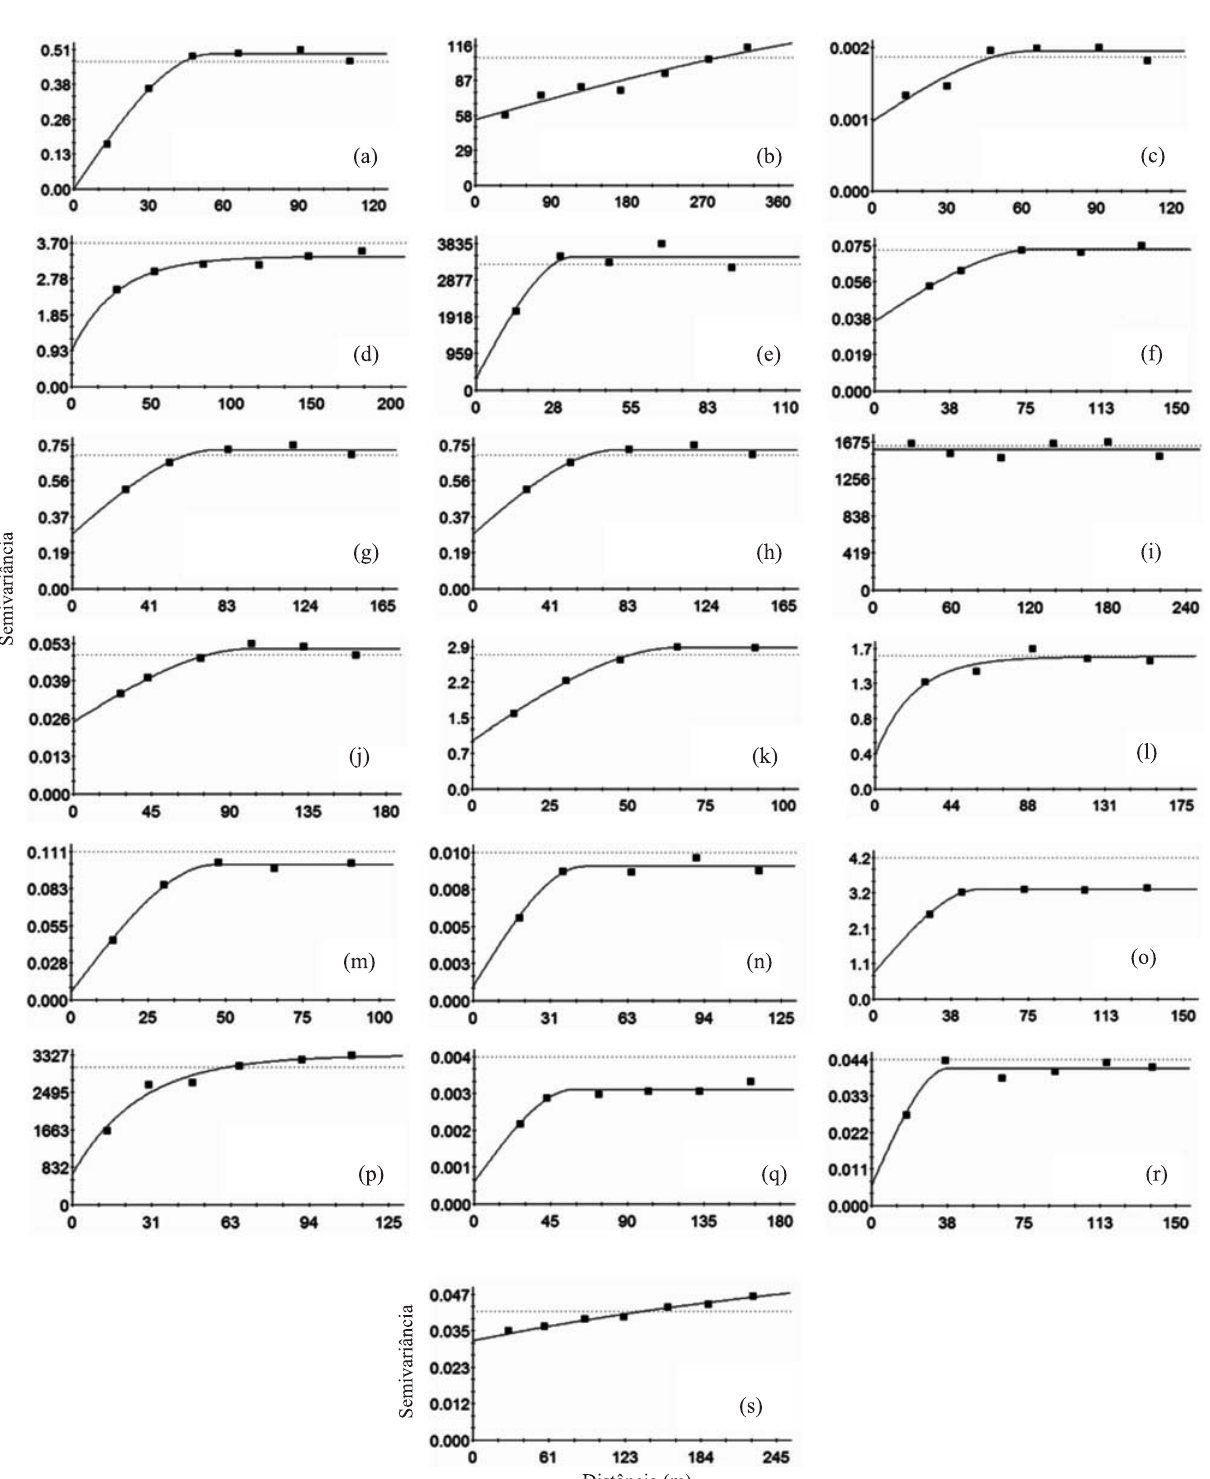
Figura 2. Semivariograma dos atributos mineralógicos: (a) FeA; (b) FeC; (c) FeA/FeC; (d) teor de Gt; (e) SI Gt; (f) DMC Gt (110); (g) teor de Hm; (h) DMC Hm (104); (i) SI Hm; (j) Gt/(Gt+Hm); (k) AlA; (l) teor de Ct; (m) Ct DMC (001); (n) IA Ct (001); (o) teor de Gb; (p) DMC Gb (002); (q) Ct/(Ct+Gb); (r) Ta Ct; e (s) Ta